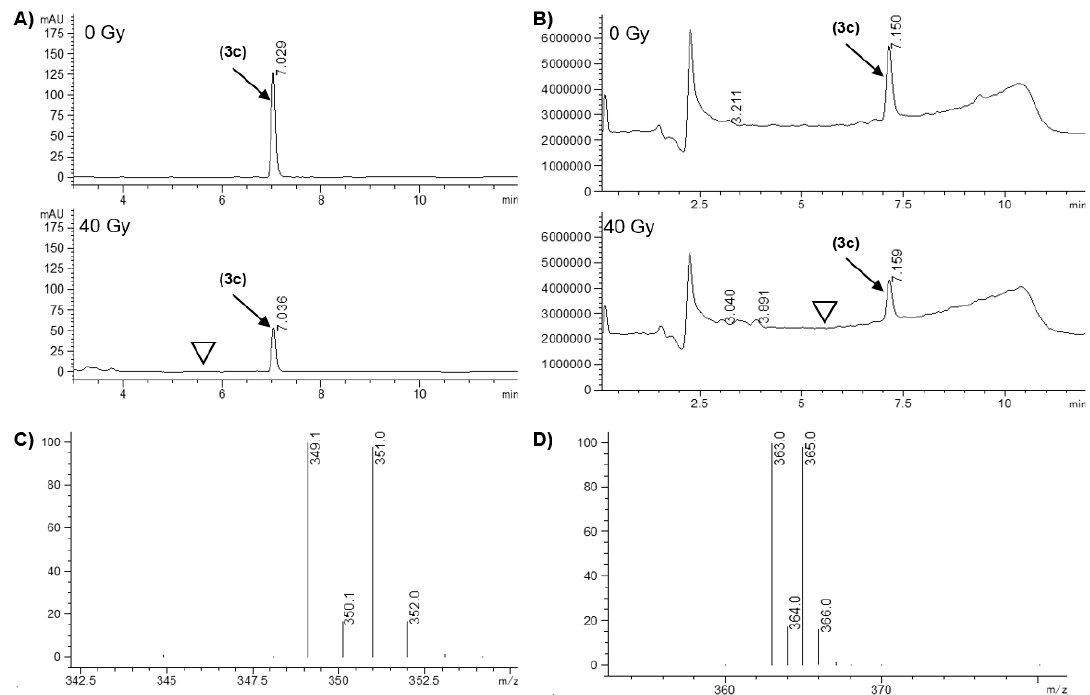
Figure 5. LC / MS analysis of the radiolytic reduction of model HAP 3c . ( A ) Diode array chromatograms at 276 nm (bandwidth 16 nm), with 0 and 40 Gy. ( B ) Total ion chromatograms (positive mode, scanning m / z 100–600), with 0 and 40 Gy. ( C ) Mass spectrum of peak at 3.891 min (identified as hydroxylamine). ( D ) Mass spectrum of peak at 7.159 min (identified as prodrug by comparison with authentic 3c ) ▽ Indicates the retention time of the parent PARPi 2c .